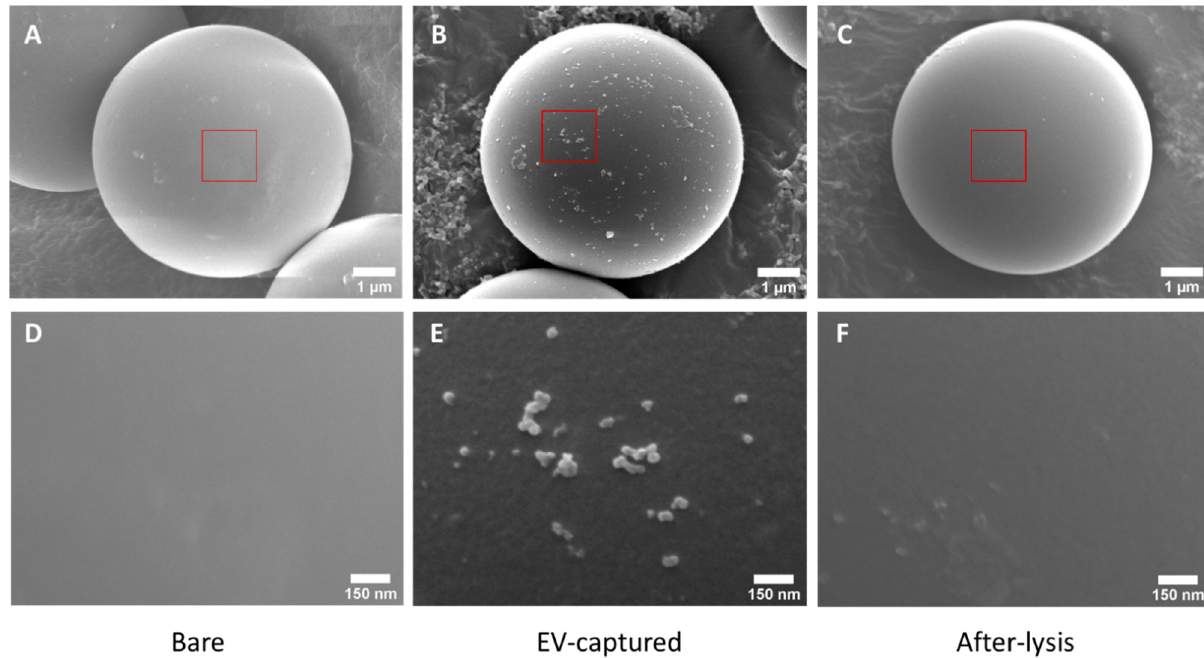
Figure 4. Morphological characterization of the bare, EV-captured and after-lysis microparticles. ( A , B ) are SEM images of a bare microparticle ( A ) and a HER2 antibody-coated microparticle ( B ) that had mixed with BT474 EV samples. ( C ) is the SEM image of the EV-captured HER2 antibody-coated microparticle after lysis. ( D – F ) show the enlarged view of the red box regions in ( A – C ).